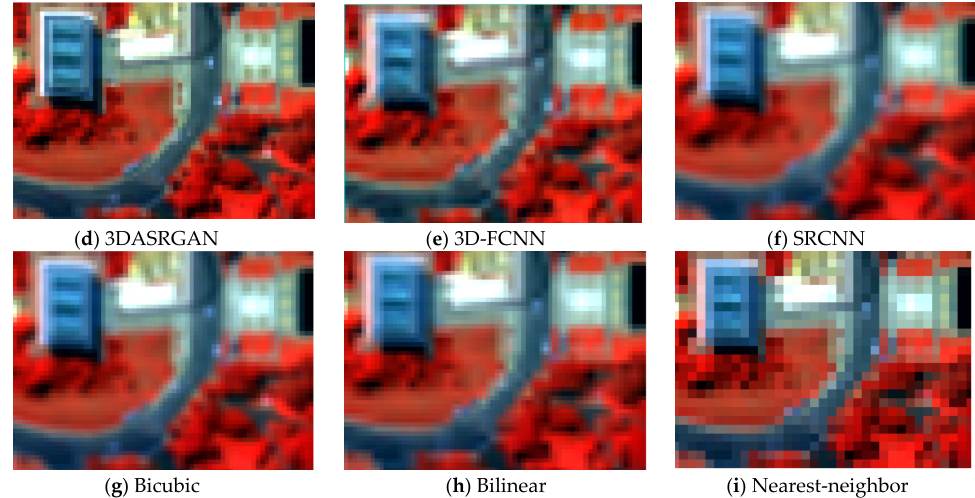
Figure 6. Image parts of different SR HSI methods and original LR and HR images based on Washington DC Mall dataset